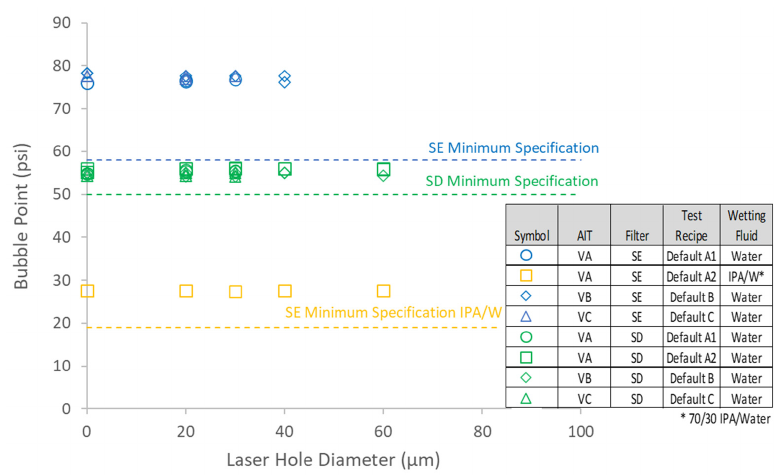
although the bubble point values as reported by AITs were insensitive to defects, they were Figure 7. Flow rate of 40 psi (276 KPa) through SE- and SD-type filters as a function of laser hole diameter. Diffusion specifications indicated in plot are from filter vendors.